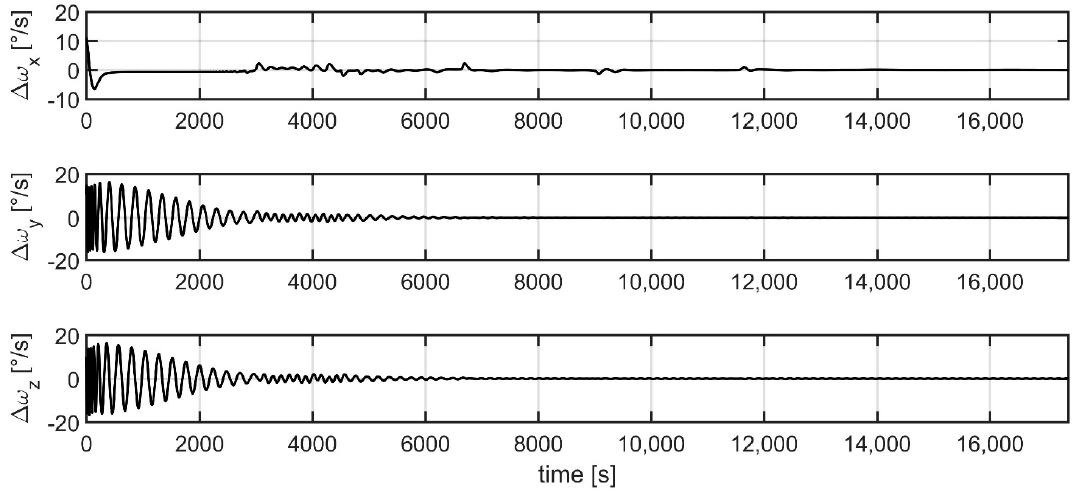
Figure 5. Di ff erence between the actual and estimated angular rates for Test Case 1. Figure 5. Difference between the actual and estimated angular rates for Test Case 1.